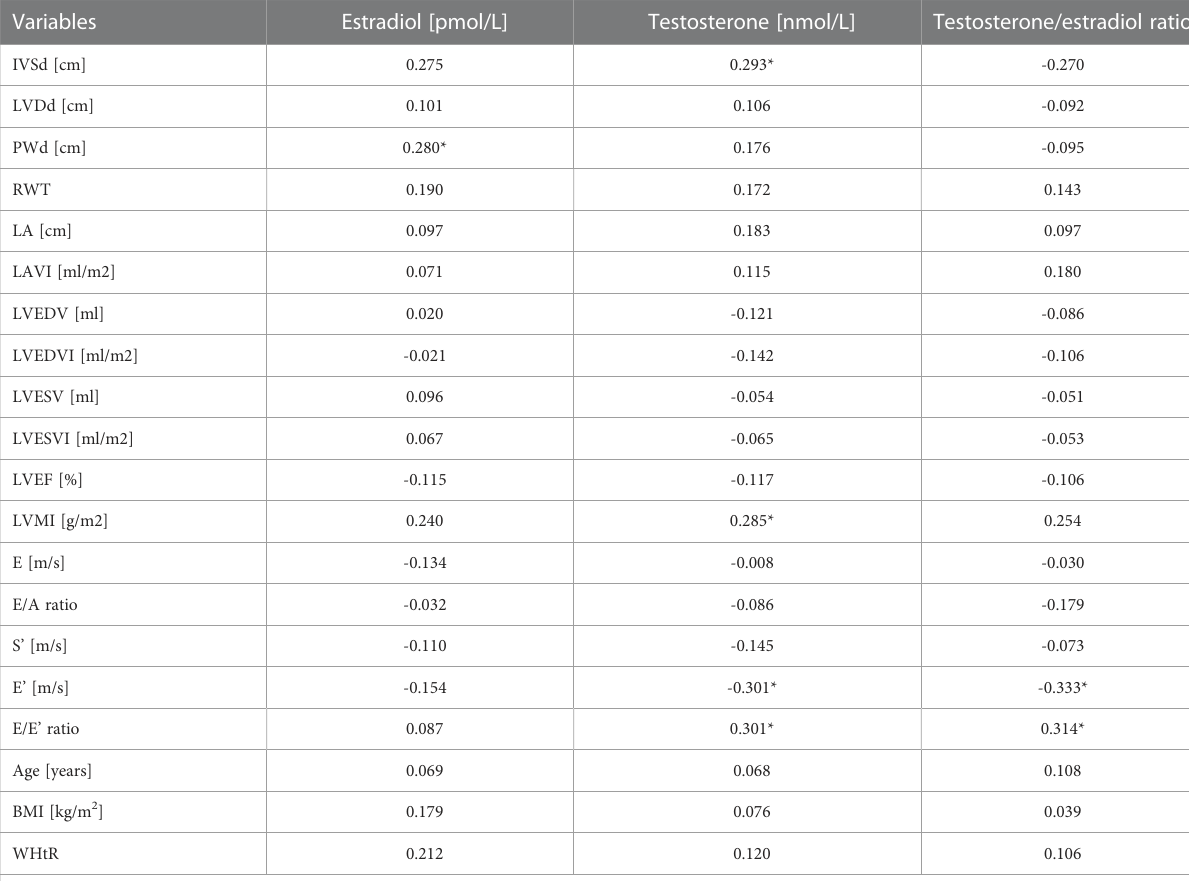
TABLE 3 Spearman ’ s correlations of serum hormones levels with echocardiographic parameters and clinical features.